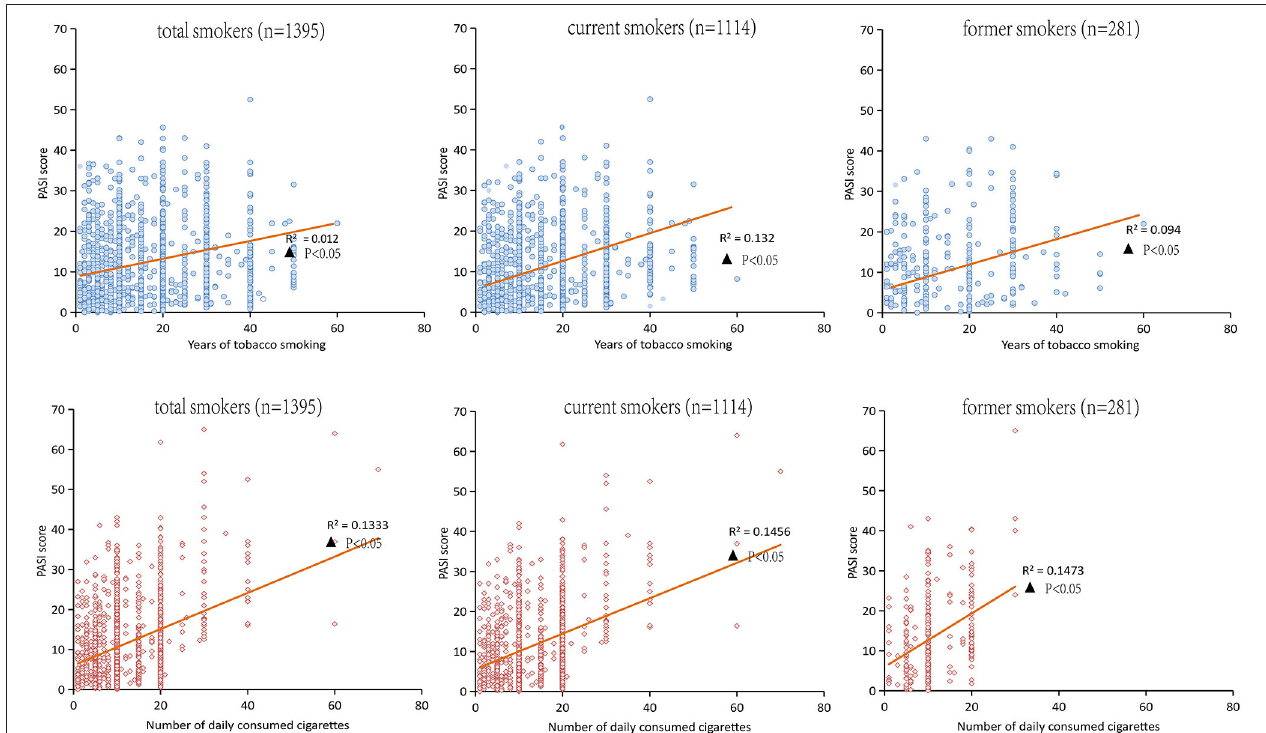
FIGURE 3 | Spearman correlation analysis for the PASI score and the years of tobacco or the numbers of daily consumed cigarettes in